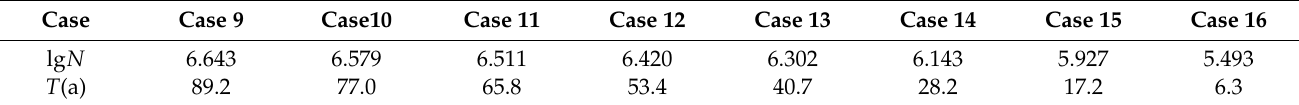
Table 8. Service lives of structures with different softening